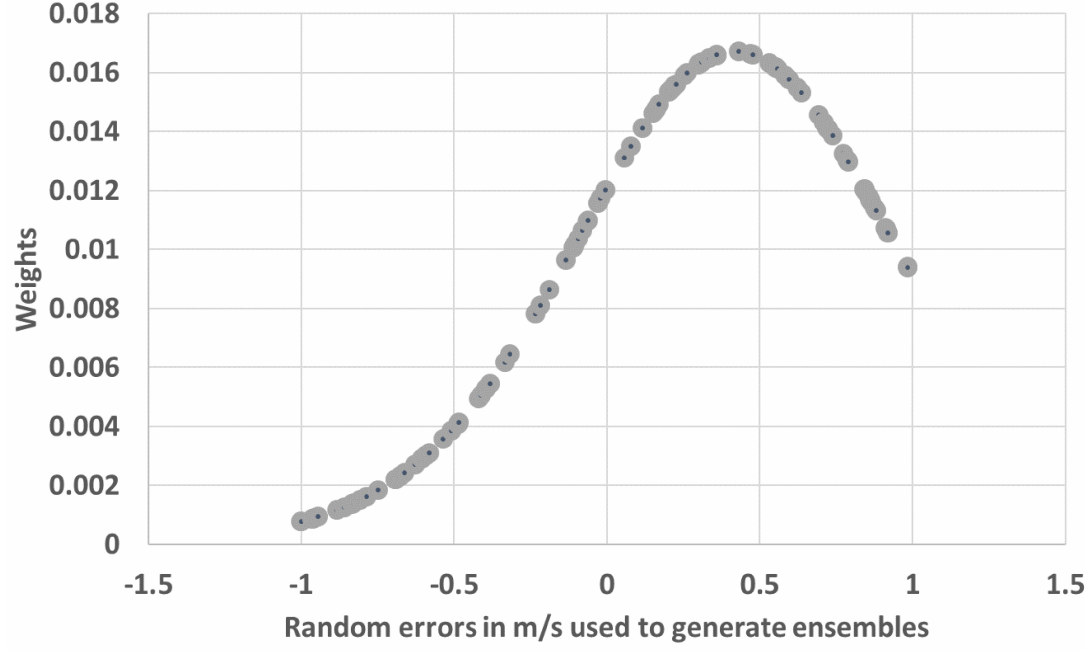
Figure 4. Variation of weights in each ensemble w.r.t introduced biases in wind